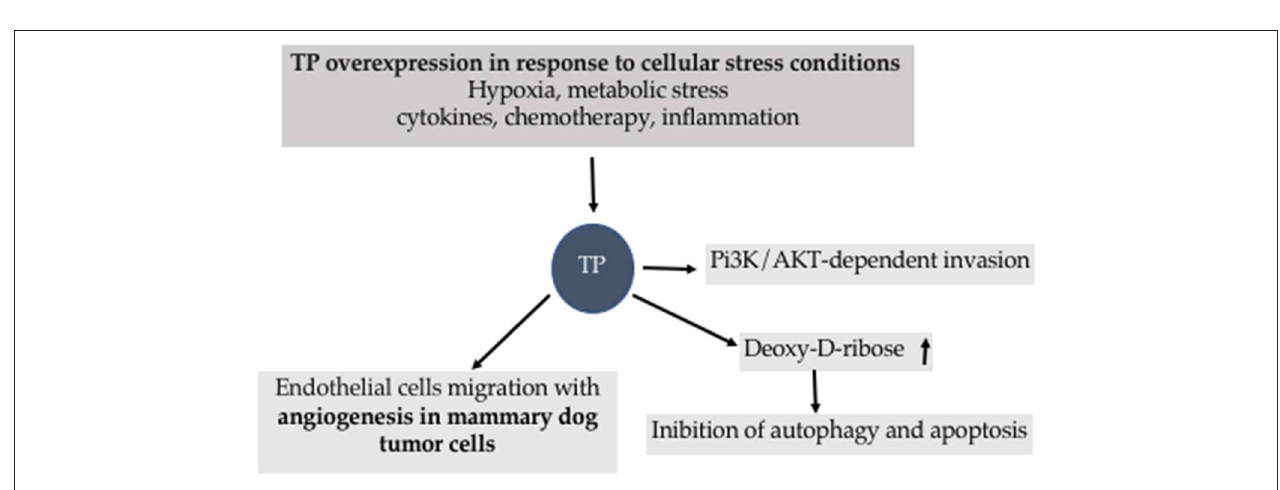
FIGURE 8 | Biological effects of Thymidine Phosphorylase